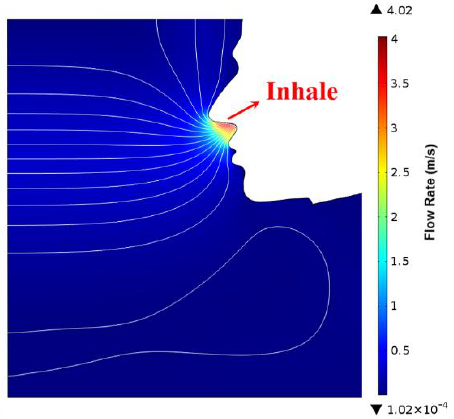
Figure 7. Simulation of human inhalation. Figure 8. Experimental setup for airflow sensor calibration.